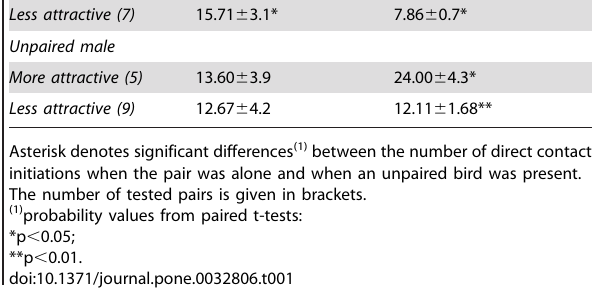
Figure 3. Relationship between a female’s contact initiations towards her partner and her tail length relative to that of an unpaired female, which indicates her relative attractiveness. Attractiveness of the focal female increases relative to the attractiveness of the unpaired female along the x-axis.